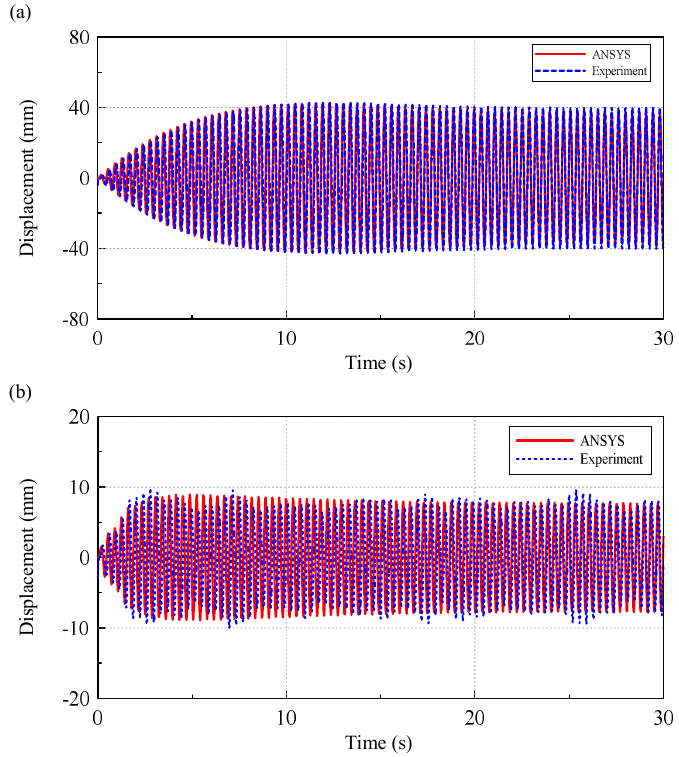
Figure 12. Dynamic displacement of RNA of OWT: ( a ) without TLD; ( b ) with TLD.